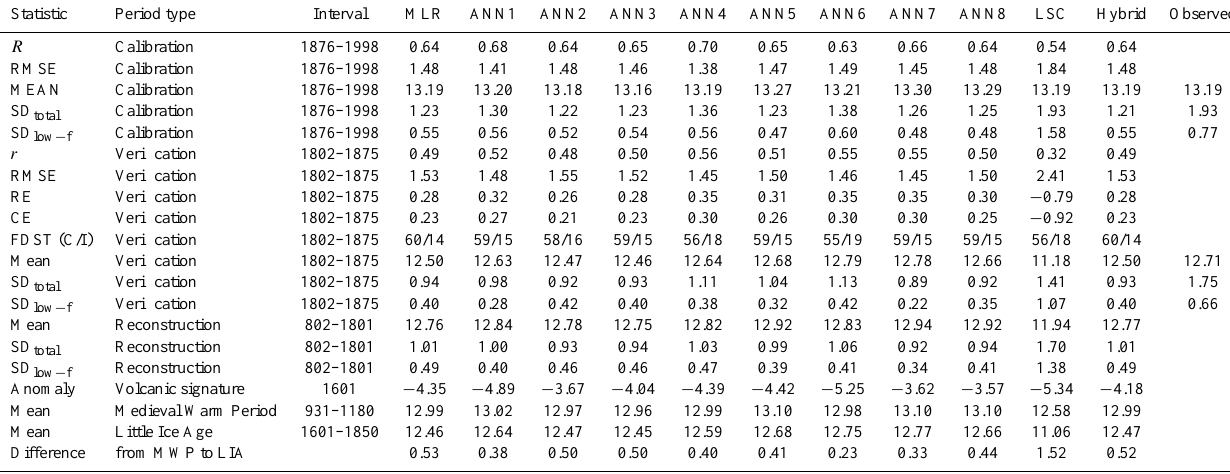
Table 2. Calibration, verification and reconstruction statistics for the three types of transfer functions, linear regression (MLR), different algorithms of artificial neural networks (ANN) and linear scaling (LSC) as well as observed temperatures. Statistics for calibration include Pearson correlation (denoted as R over calibration period and r for verification period), root mean square error (RMSE; Eq. 5) and mean (Mean) and standard deviation (SD total ) of the temperature variability. SD was further calculated from the data filtered by 15-year cubic splines to portray the low-frequency variability (SD low − f ) . Additional statistics for verification include reduction of error (RE; Eq. 6), coefficient of error (CE; Eq. 7) and first difference sign test (FDST) with correct (C) and incorrect (I) differences. In addition, the temperature anomaly (relative to calibration mean) during the volcanic year AD 1601 as well as the mean temperatures for the Medieval Warm Period (MWP) and the Little Ice Age (LIA) and the reconstructed temperature difference from the former to the latter, were computed.